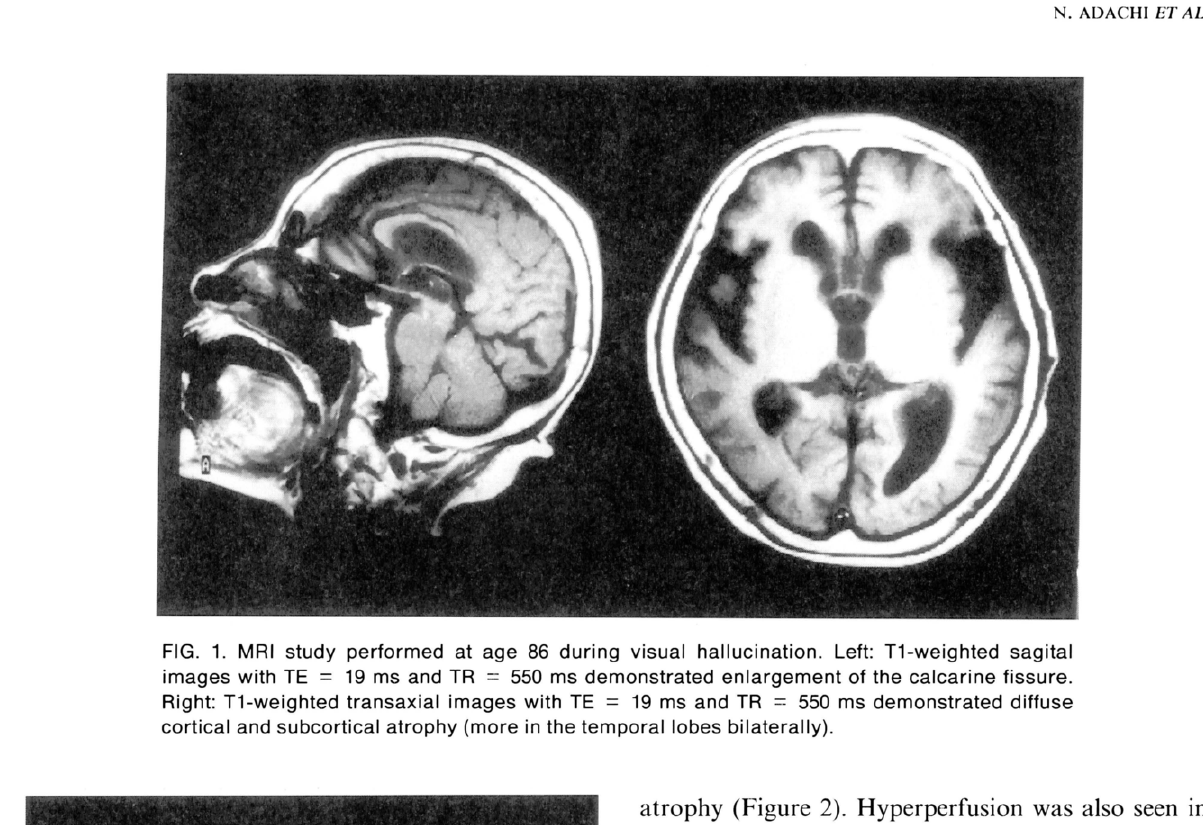
FIG. 1. MRI study performed at age 86 during visual hallucination. Left: T1-weighted sagital images with TE = 19 ms and TR == 550 ms demonstrated enlargement of the calcarine fissure. Right: T1-weighted transaxial images with TE == 19 ms and TR == 550 ms demonstrated diffuse cortical and subcortical atrophy (more in the temporal lobes bilaterally).